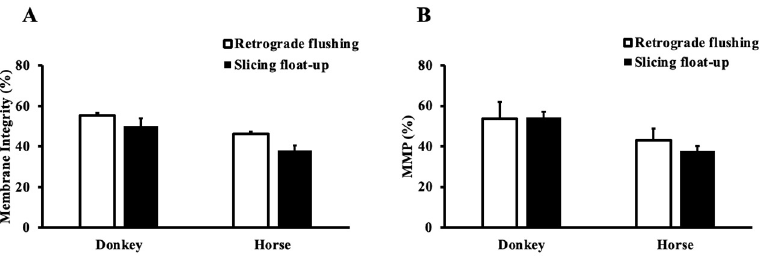
Figure 4. Sperm plasma membrane integrity ( A ) and mitochondrial membrane potential(MMP) ( B ) of frozen-thawed epidydimal sperm harvested via retrograde flushing of the tail of the epididymis followed by slicing float-up in the donkey and the horse. MMP represents the percentage of intact sperm with high mitochondrial membrane potential.